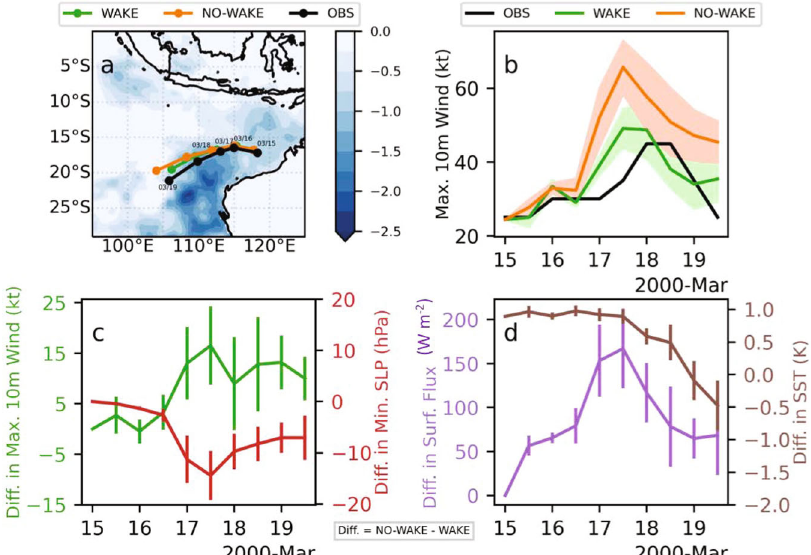
Fig. 3 Simulating MJO ’ s impact on TC Olga (2000). a Track of TC Olga from observations (black) and model simulations (WAKE (green) and NO-WAKE (orange)). While the “ WAKE ” case represents the set of simulations where the model is forced by observed SST, the “ NO-WAKE ” case represents the set of simulations where the model is forced by SSTs from which the in fl uence of MJO is removed. Both “ WAKE ” and “ NO- WAKE ” each consist of 8 simulations and the ensemble mean tracks are shown. The color in the background represents the SST change induced by prior MJO, just before Olga ’ s formation on 15 March 2000. Dates are shown near tracks to indicate the direction of Olga ’ s movement. b Time evolution of Olga ’ s 10 m maximum winds (kt) from observations and model simulations. Time evolution of difference between NO-WAKE and WAKE simulations for ( c ) 10 m maximum wind (kt, green) and minimum sea-level pressure (hPa, red), and ( d ) along- track pre-storm SST (°C, brown) and enthalpy fl ux at the air – sea interface under the storm (W m − 2 , purple). As in panel ( a ), ensemble mean values are shown in panels ( b – d ). The shading in panel ( b ), and the vertical bars in panels ( c , d ), indicate the ensemble spread as represented by the